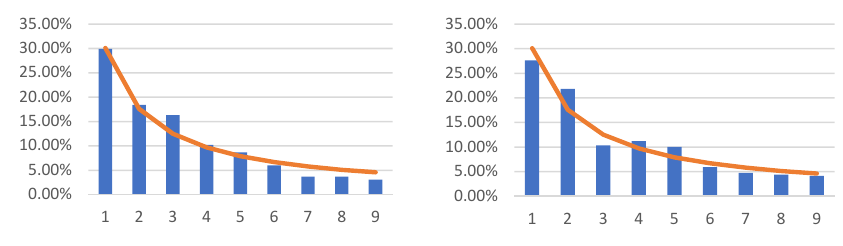
Figure 1. Actual and Benford ’ s law expected frequency distributions